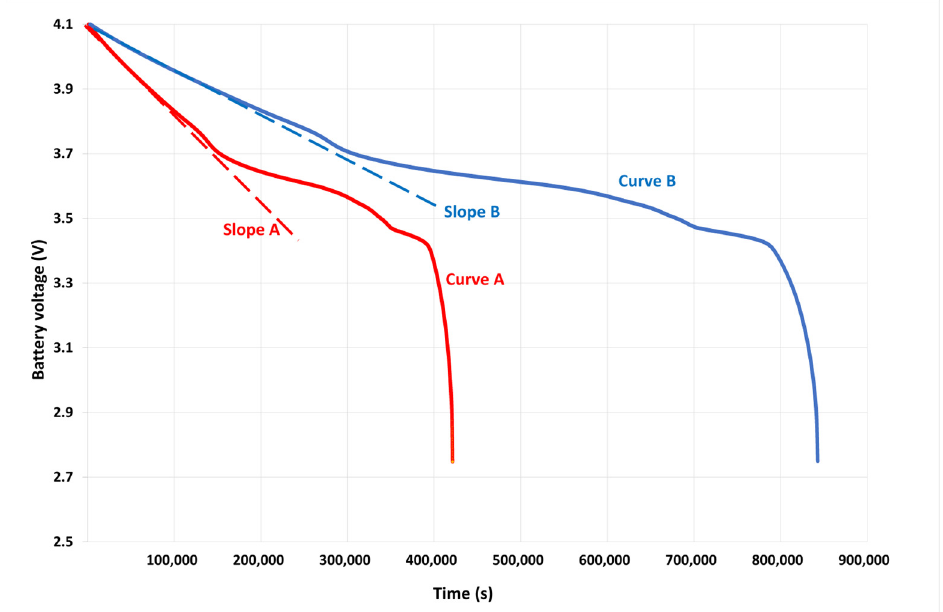
Figure 13. Evolution with the time of the battery voltage for two different currents (curves A and B) and initial discharge slopes (slopes A and B).